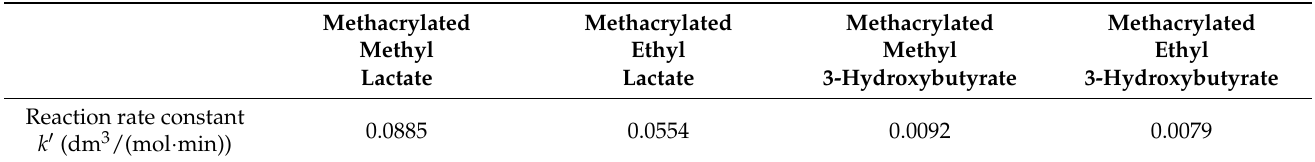
Table 5. The calculated values of reaction rate constants ( k (cid:48) ) for methacrylation of alkyl esters of lactic and 3-hydroxybutyric acid from the slope of the graphic solutions.